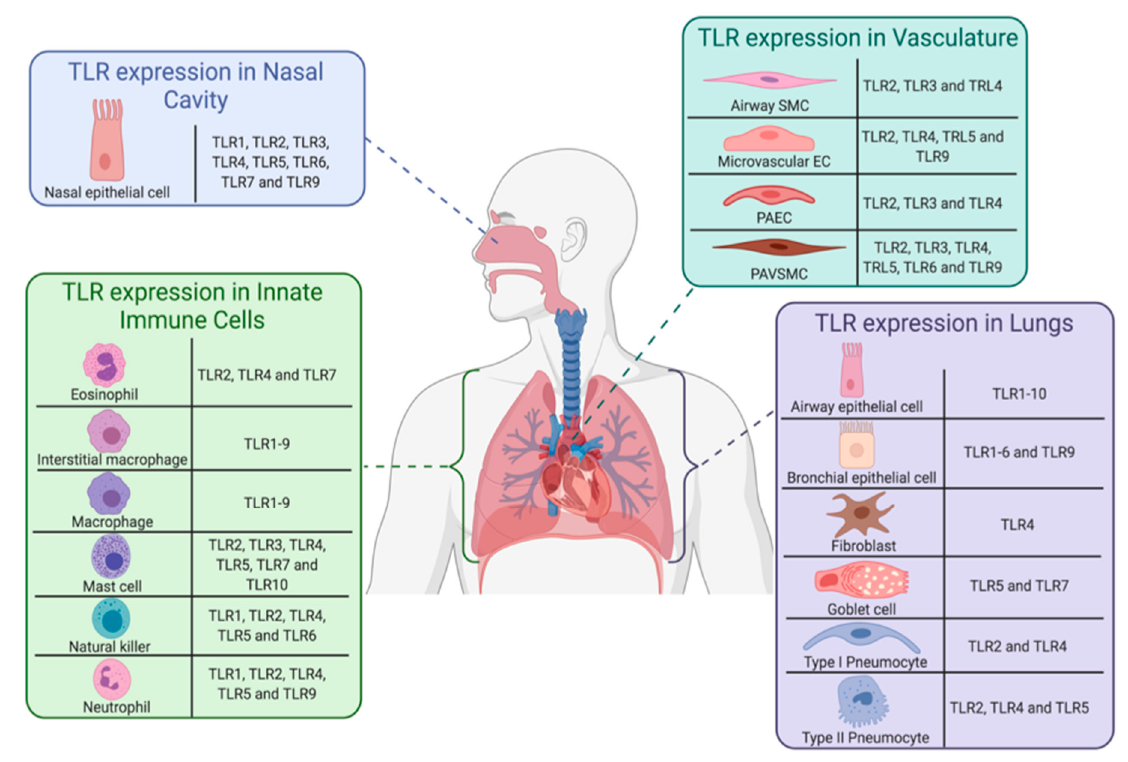
Figure 3. Expression of functional toll-like receptors in specific cell populations of the human respiratory system. Functional expression of TLR1-10 has been reported in human pulmonary tissue [57]. However, there are limited studies available investigating TLR expression in specific cell populations within human respiratory tissue. This illustration depicts expression of TLRs in the nasal cavity (TLR1-7 and TLR9 [67,68]) and specific cell populations in located pulmonary tissue, including innate immune cells (eosinophils: TLR2, TLR4, and TLR7 [69,70]; interstitial macrophages: TLR1-9 [71]; macrophages: TLR1-9 [71,72]; mast cells: TLR2-5, TLR7, and TLR10 [73]; natural killer cells: TLR1, TLR2, TLR4, TLR5, and TLR6 [74]; and neutrophils TLR1, TLR2, TLR4, TLR5, and TLR9 [75]), vasculature (airway SMCs: TLR2-4 [76]; microvascular ECs: TLR2, TLR4, TLR5 and TLR9 [77]; PAECs: TLR2-4 [78–80]; and PAVSMCs: TLR2-6 and TLR9 [77,81]) and lung cells (airway epithelial cells: TLR1-10 [82,83]; bronchial epithelial cells: TLR1-6 and 9 [83]; fibroblasts: TLR4 [84]; goblet cells: TLR5 and TLR7 [70]; type I pneumocytes: TLR2 and TLR 4 [85]; and type II pneumocytes: TLR2, TLR4, and TLR5 [70,85]). These cells may contribute to severe immunopathological manifestations experienced by COVID-19 patients, and may be novel entry points used by SARS-CoV-2 for host cell infection. Abbreviations: Endothelial cell, EC; pulmonary artery endothelial cell, PAEC; pulmonary artery vascular smooth muscle cell, PAVSMC.